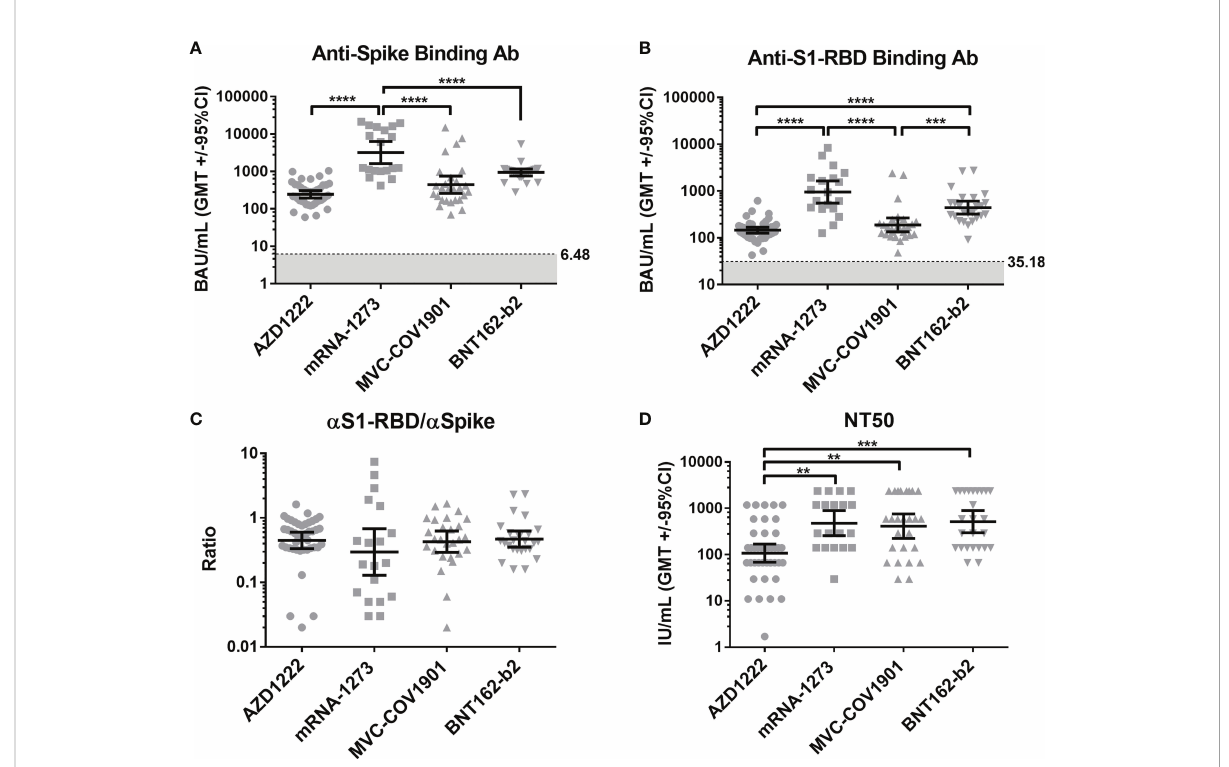
FIGURE 1 Compare the serological response triggered by different vaccine brands. (A) The levels of anti-spike binding antibody and (B) anti-S1-RBD binding antibody in the sera of four vaccinee groups (AZD1222, mRNA-1273, MVC-COV1901, and BNT162-b2) were evaluated by indirect ELISA. The mean value from the pre-pandemic serum group was determined as the cutoff value (grey). (C) The ratio of anti-S1-RBD to anti-spike binding antibody was shown. (D) Comparison of sera ’ s neutralizing antibodies titers (NT50) in different COVID-19 vaccine groups. **P<0.01, ***P<0.001,